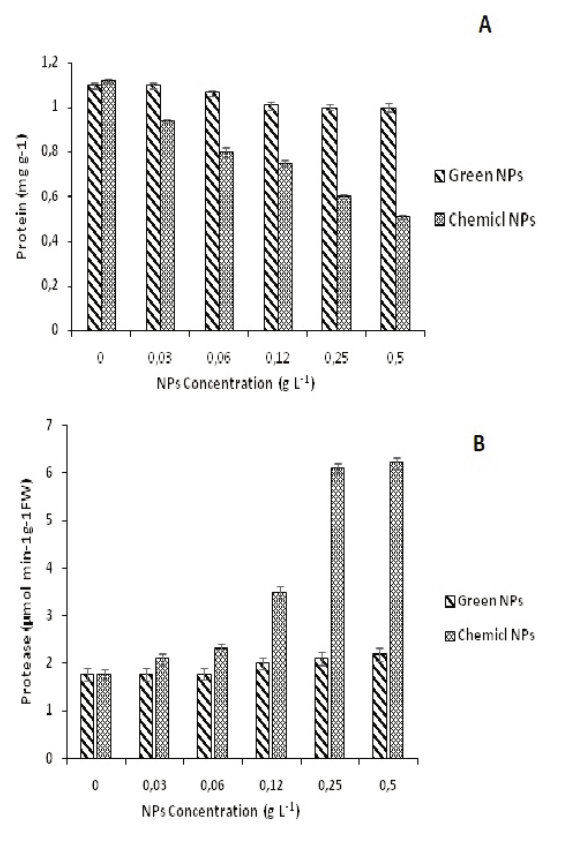
Fig. 7 ­ The influence of AgNPs type and concentration on activi­ ties of peroxidase (A) and catalase (B) in Allium cepa . Means ± SD of six replicates. The same letter denotes lack of a statistically significant difference (Tukey,